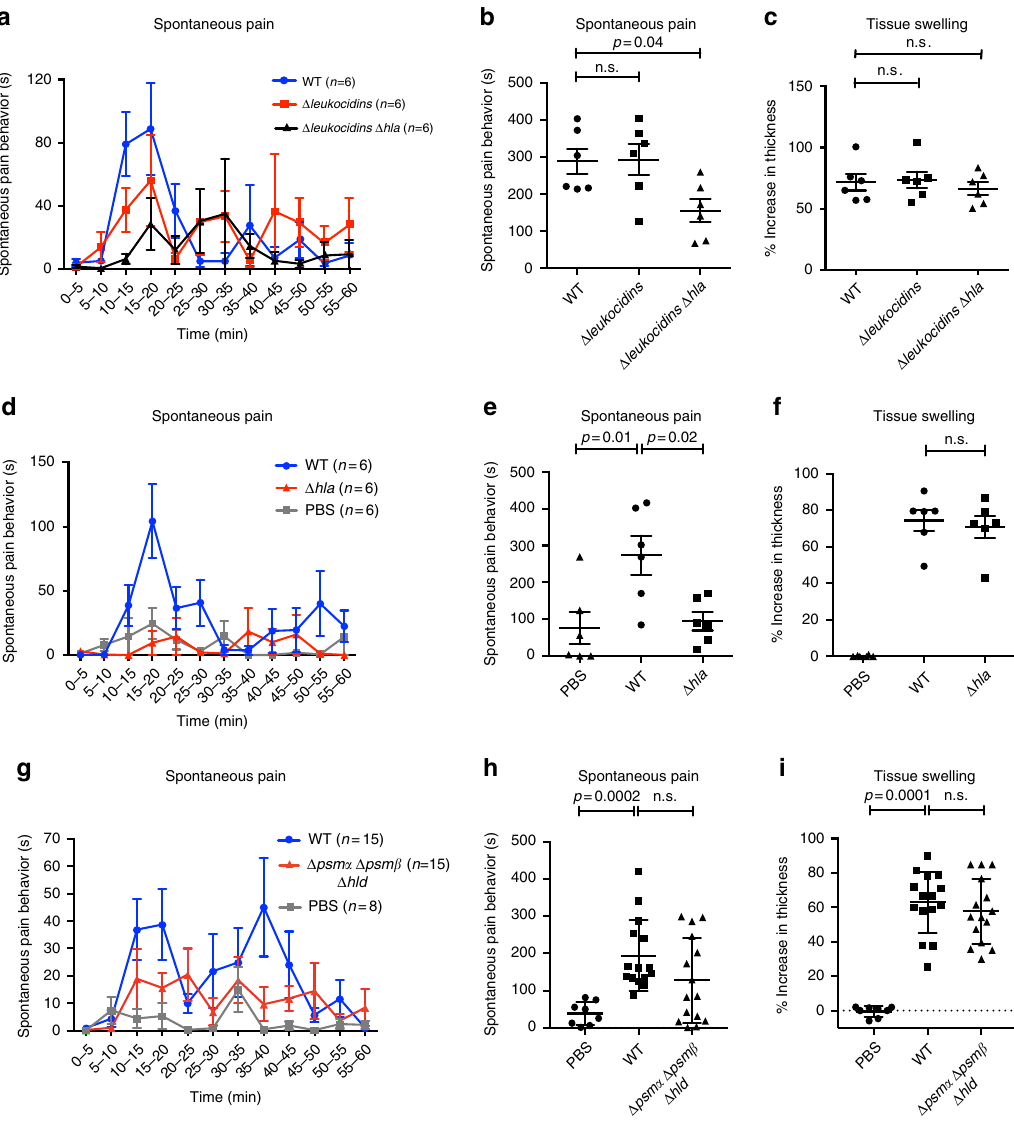
Fig. 4 Alpha-hemolysin is necessary for spontaneous pain during live S. aureus infection. Mice were infected with WT or isogenic mutant strains of S. aureus lacking speci fi c PFTs (USA300, 5 × 10 8 CFU) to determine the role of distinct toxins in spontaneous pain production. a Time course of spontaneous pain re fl exes plotted over 5-min intervals after infection with WT S. aureus , Δ leukocidins , or Δ leukocidins Δ hla isogenic mutant S. aureus . n = 6 mice per group. b Quanti fi cation of pain over 60 min of infection with WT, Δ leukocidins , or Δ leukocidins Δ hla S. aureus. n = 6 mice per group. c Measurement of tissue swelling after infection with WT, Δ leukocidins Δ hla , or Δ hla S. aureus . n = 6 mice per group. d Time course of spontaneous pain behavior for WT vs. Δ hla S. aureus . n = 6 mice per group. e Quanti fi cation of pain over 60 min of infection with WT vs. Δ hla S. aureus . n = 6 mice per group. f Measurement of tissue swelling after infection with WT vs. Δ hla S. aureus . Hla contributes only to spontaneous pain. n = 6 mice per group. g Time course of spontaneous pain behavior for PBS vs. WT S. aureus vs. S. aureus de fi cient in all phenol-soluble modulins (PSMs) ( Δ psm α Δ psm β Δ hld ). n = 8 – 15 mice per group. h Quanti fi cation of spontaneous pain after infection with PBS ( n = 8 mice per group) vs. WT ( n = 14 mice per group) vs. Δ psm α Δ psm β Δ hld ( n = 15 mice per group) S. aureus over 60 min. i Measurement of tissue swelling after infection with PBS ( n = 8 mice per group) vs. WT S. aureus ( n = 14 mice per group) vs. S. aureus de fi cient in all PSMs ( n = 15 mice per group). b – i : p values, one-way ANOVA with Tukey ’ s post-tests. a – f N = 2 replicates; g – i N = 4 replicates. Error bars throughout fi gure, mean ± PFTs are necessary for S. aureus -induced spontaneous pain .